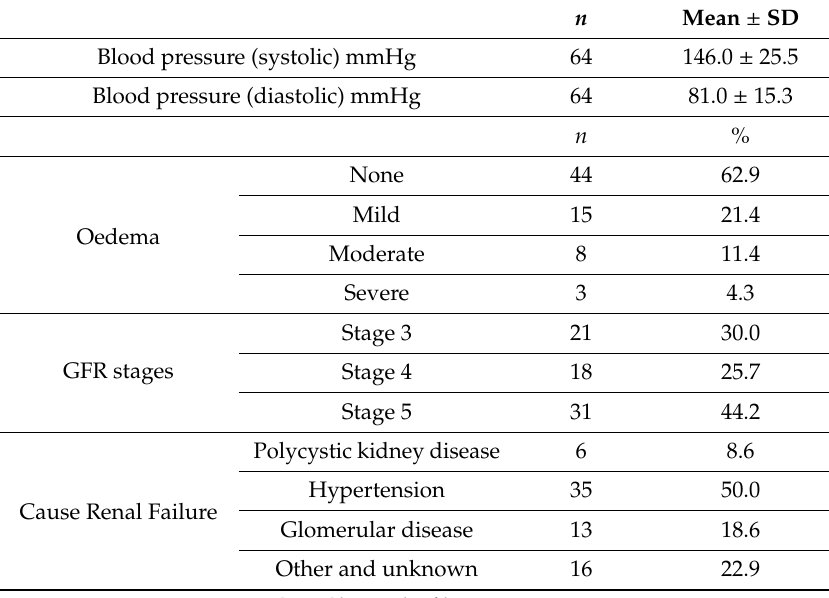
Table 2. Clinical data of